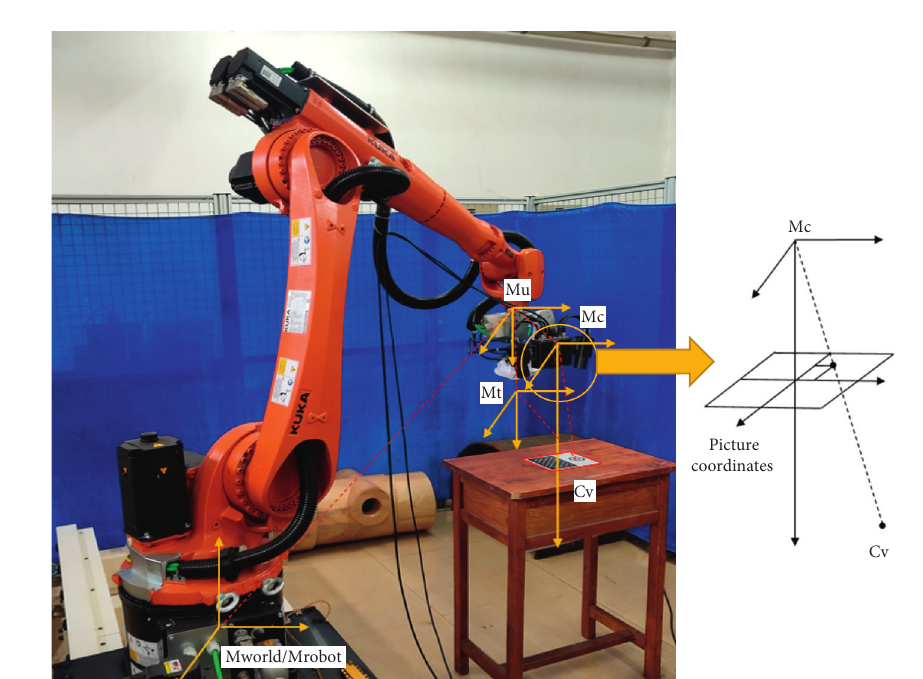
Figure 13: Experimental set-up for establishing the hand-target-eye space pose conversion